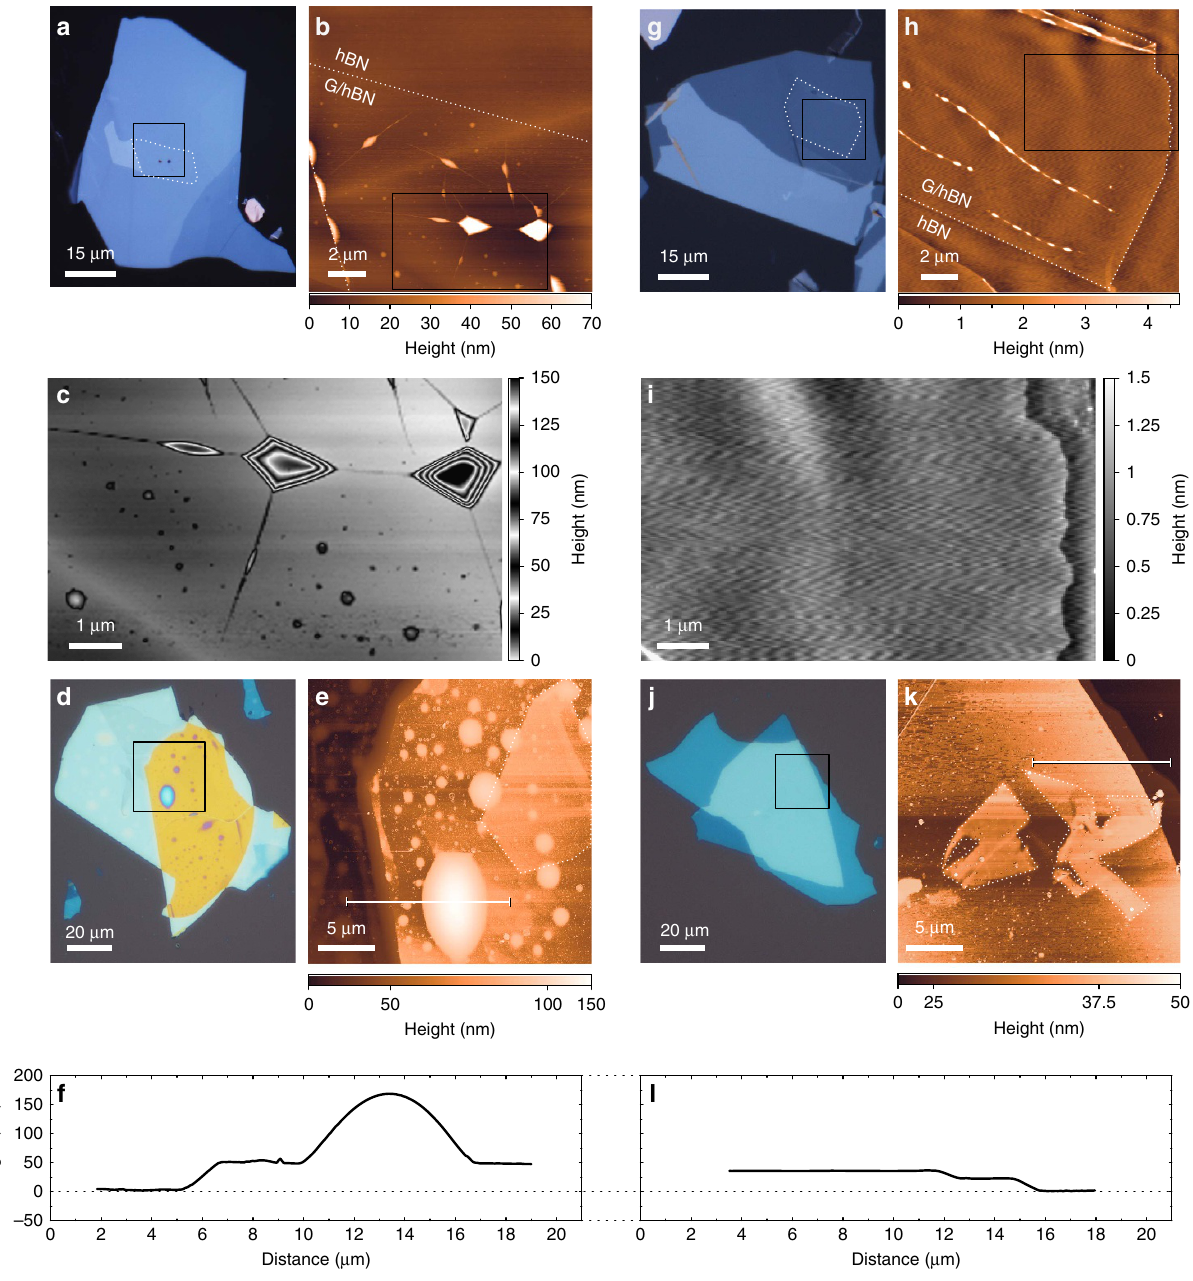
Figure 3 | Atomic force microscopy characterization of blister formation at different assembly temperatures. ( a ) Optical image of graphene/hBN stack on PPC (after step iv in Fig. 1f), picked up from pristine SiO 2 at 40 (cid:2) C. ( b ) AFM topography image of region indicated in ( a ) – blisters are visible across the stacked region in AFM with heights of E 50nm. ( c ) The marked region in b with periodic colourscale to emphasize height variations across blisters. ( d ) Optical image of G/hBN stack dropped down onto a second hBN flake after approaching at 40 (cid:2) C on SiO 2 (step vii in Fig. 1f). Many hemispherical blisters are visible over the stack surface. ( e ) AFM topography image. Encapsulated graphene flake is visible, indicated by dotted line. ( f ) topography line profile of blister from indicated region in d . Panel g as a , but with pick-up performed at 110 (cid:2) C. ( h ) AFM image shows smaller overall height variation and large blister-free regions. ( i ) The marked region in h have two orders of magnitude less height variation compared with the region c of same size. Panel j as d , but with drop-down performed at 110 (cid:2) C. No trapped blisters are visible optically or ( k ) in the AFM scanned region. Encapsulated few-layer graphene regions are indicated. ( l ) AFM line profile from i showing uniform height across the